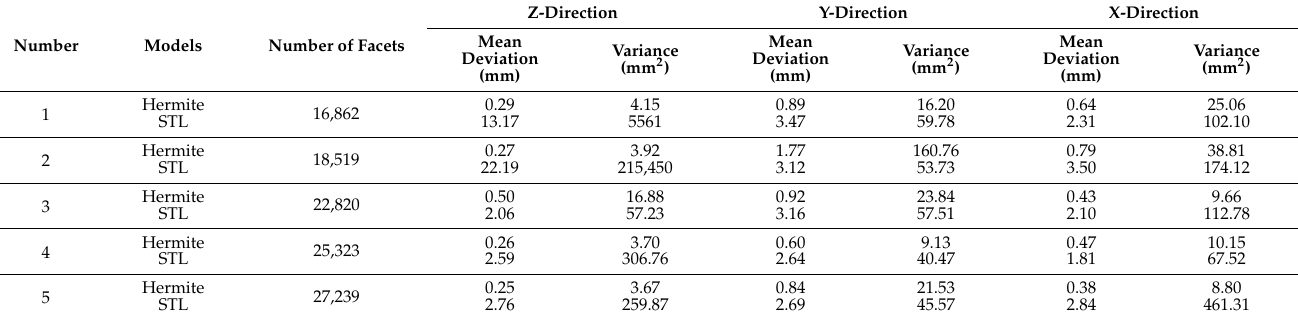
Table 1. Results of model fitting errors.